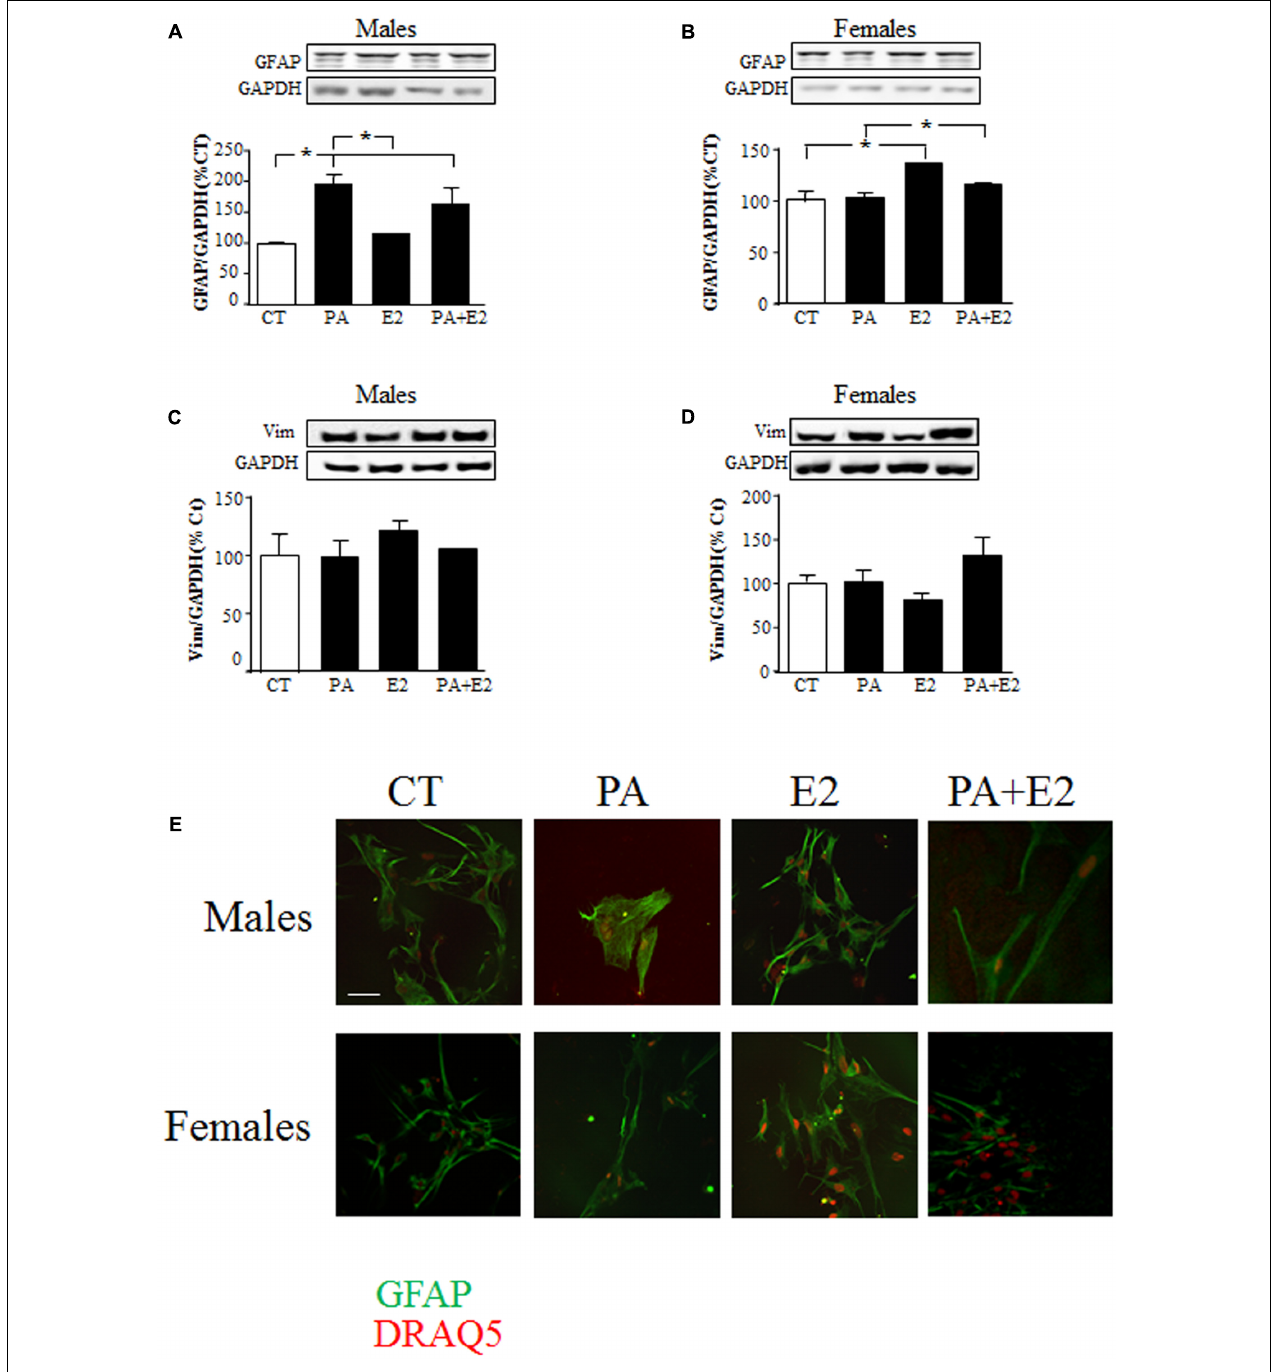
FIGURE 4 | Effects of PA and 17 β E2 on astrocytes markers. Astrocyte cultures were treated with PA (0.5 mM), E2 (10 − 10 M) or the combination of both. Immunoblots were probed with antibodies toward GFAP in males (A) , and females (B) ; Vimentin in males (C) ; and females (D) . The average of three independent assays performed in duplicate is shown. Statistical significance: ∗ p < 0.05. Immunocytochemistry for GFAP and nuclear DRAQ5 staining (E) . Scale bar, 50 µ m.